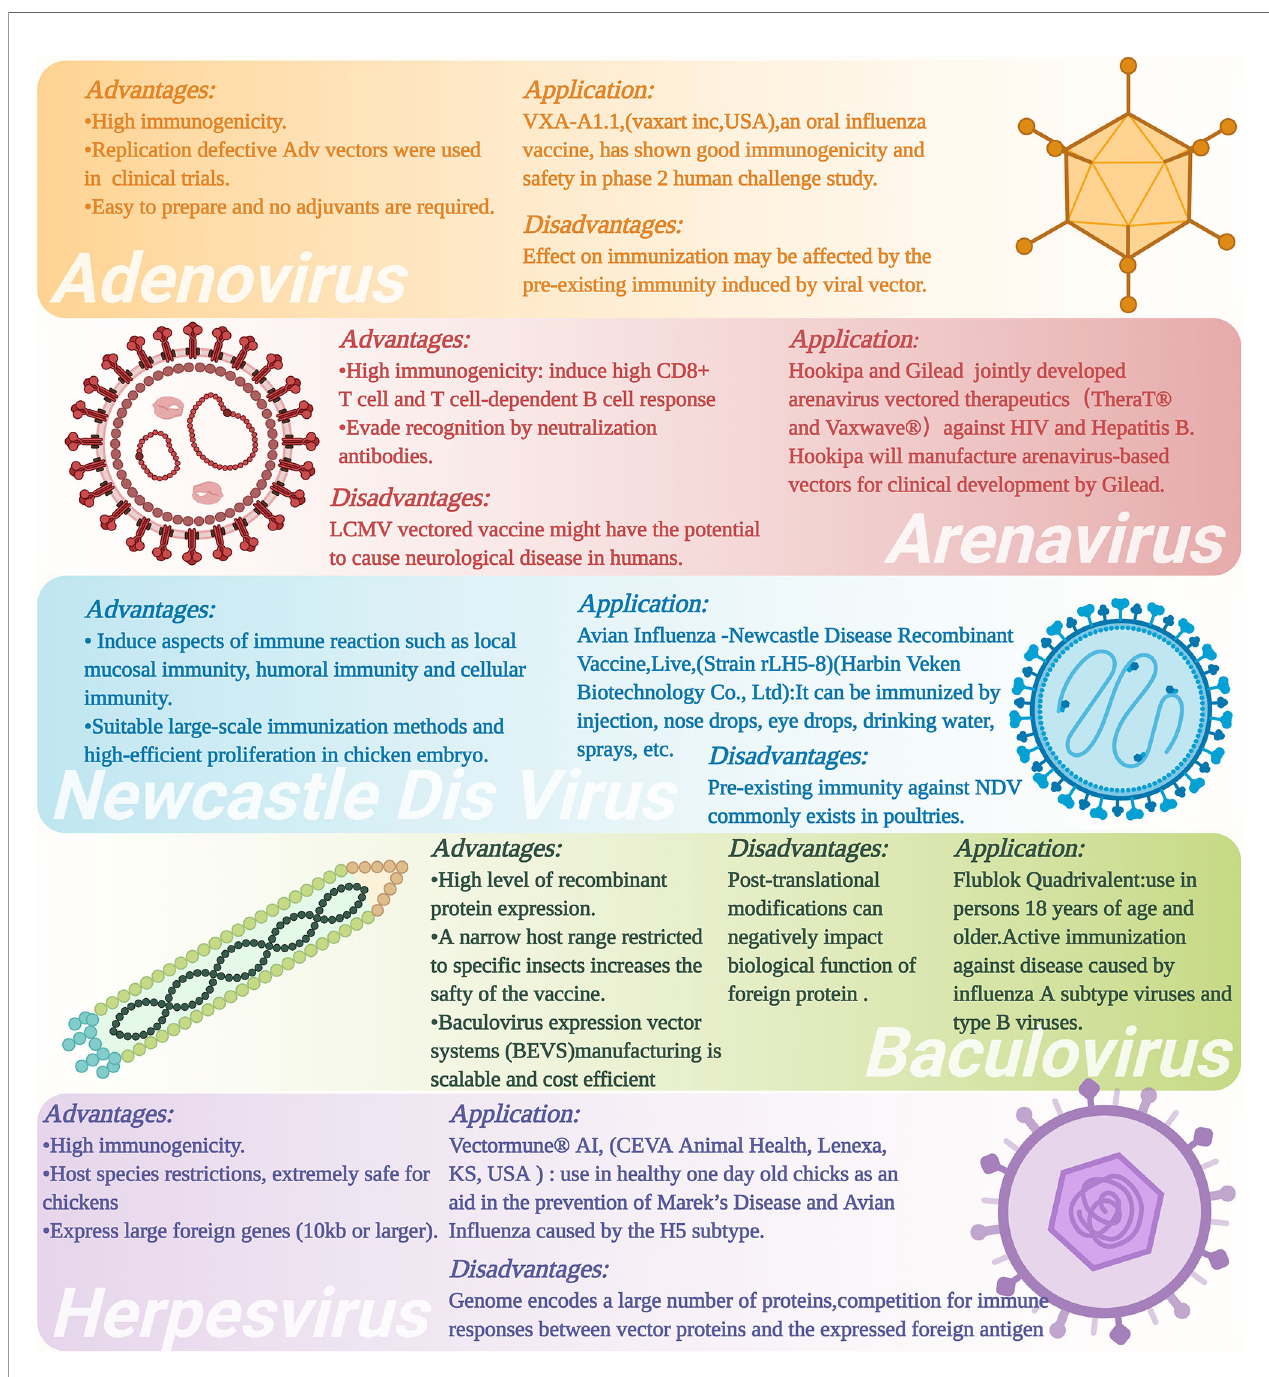
FIGURE 3 | Advantages and disadvantages as well as applications of different types of viral vectors and viral vectored vaccines. The fi gure was created with Biorender